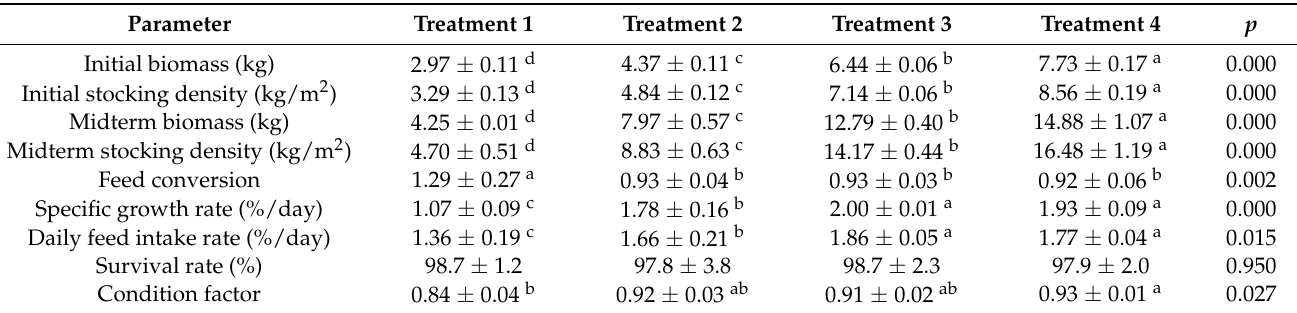
Table 2. Growth performance of olive flounder Paralichthys olivaceus cultured at four different initial stocking densities for 4 weeks.